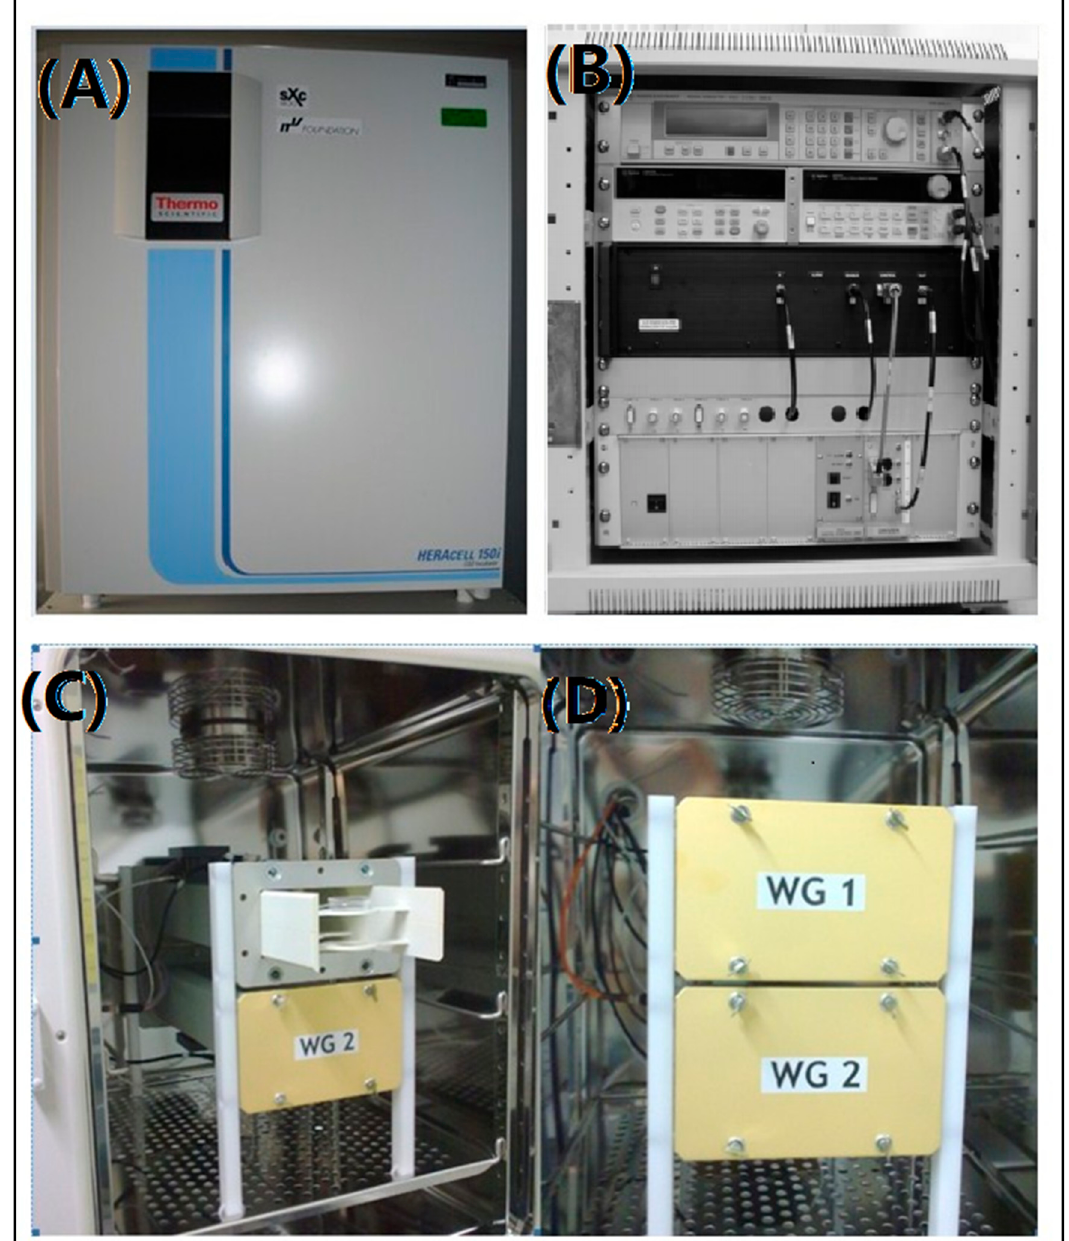
Figure 1. The sXc 1800 MHz exposure system. ( A ) The sXc 1800 MHz exposure system; ( B ) signal unit; ( C ) cell dish holder; ( D ) two waveguides.